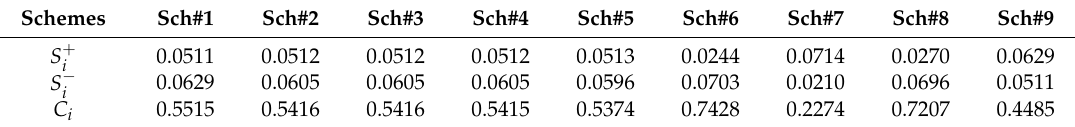
Table 6. Distance to PIS, Distance to NIS and similarity of each feasible scheme in Case